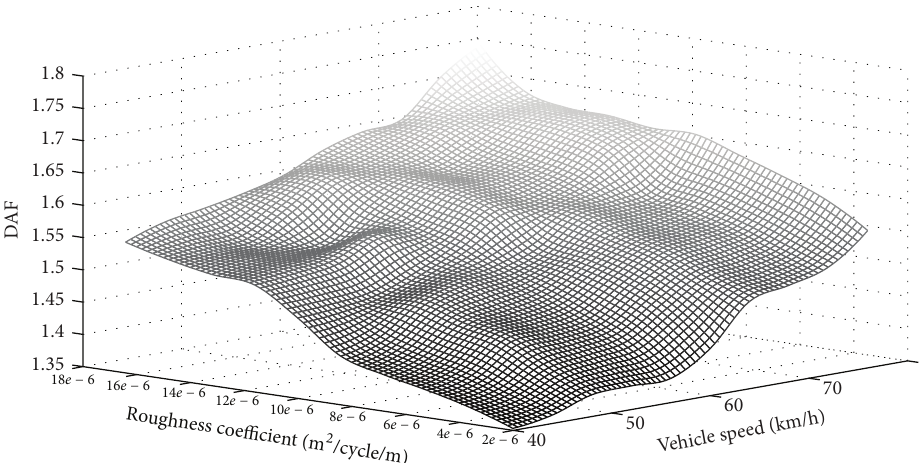
Figure 28: Dynamic amplification factor with vehicle speed and bridge surface roughness.